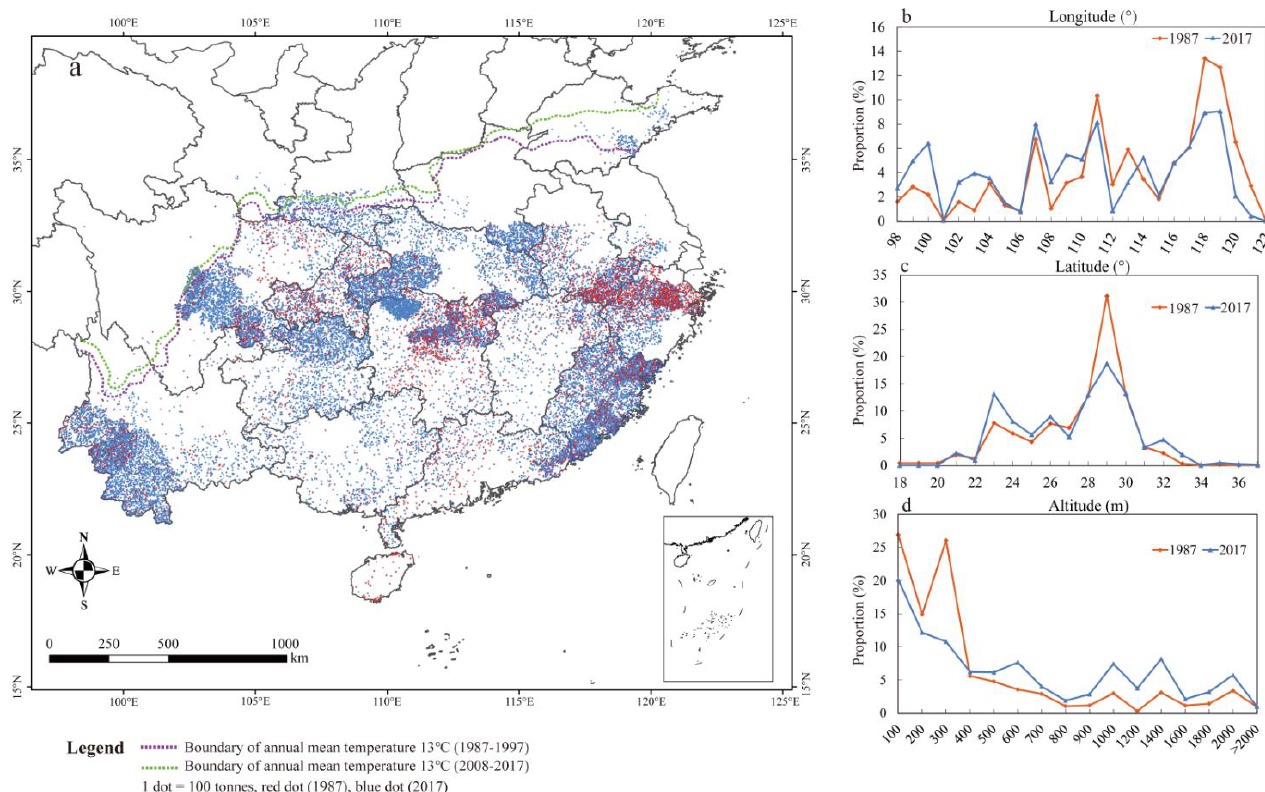
Figure 4. Spatial and elevation distribution of tea production in 1987 and 2017. ( a ) Annual tea production in 1987 and 2017, and mean temperature in 1987 – 1997 (red) and 2008 – 2017 (blue). Distribution of the tea production proportion (percentage of total annual production) by longitude ( b ), latitude ( c ), and altitude ( d ).